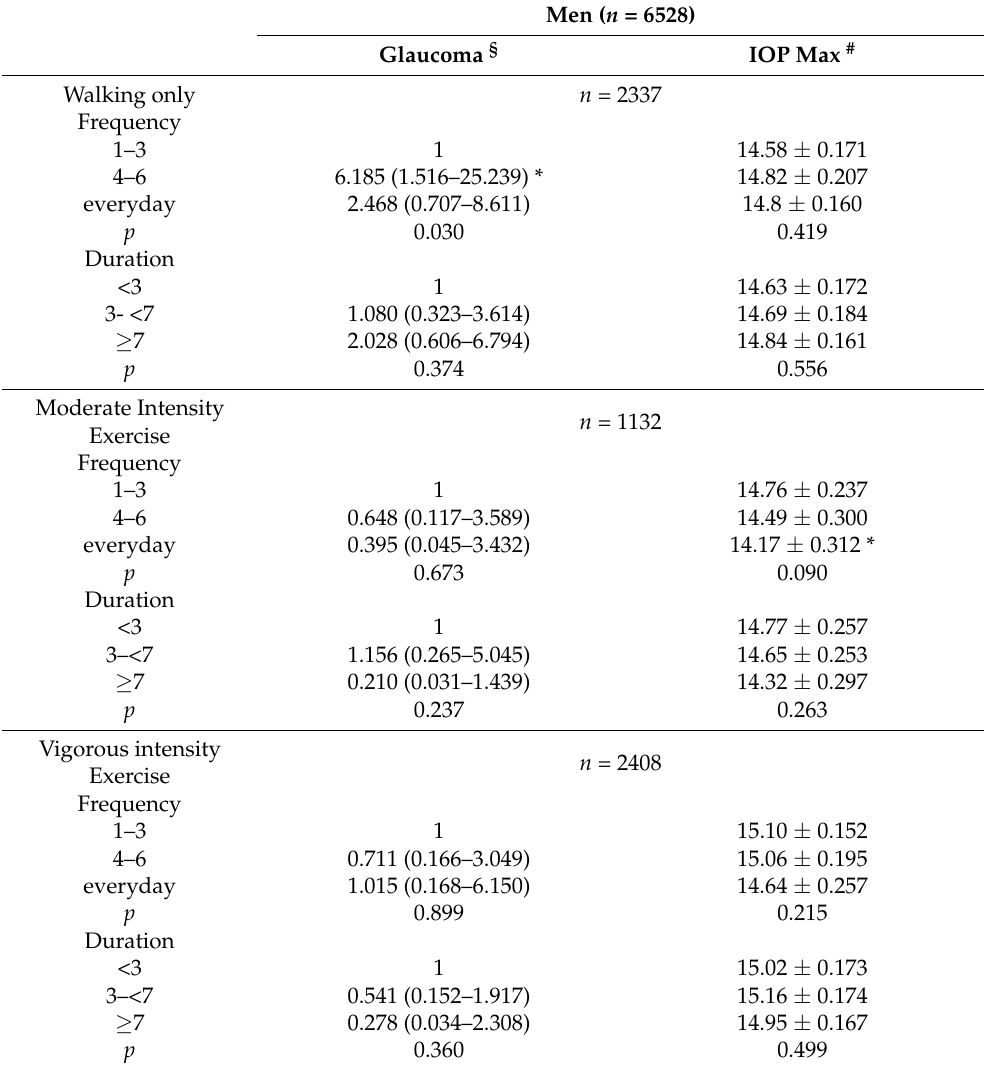
Table 3. Regression analysis of glaucoma and intraocular pressure according to the frequency or duration of physical activity in